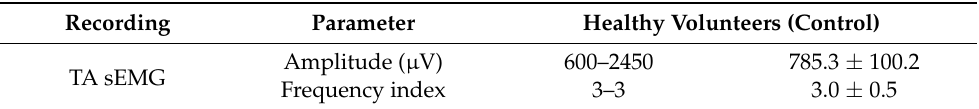
Table 3. Reference values of surface electromyography (sEMG) parameters that were recorded during an attempt of maximal contraction in a group of healthy volunteers (N = 45).